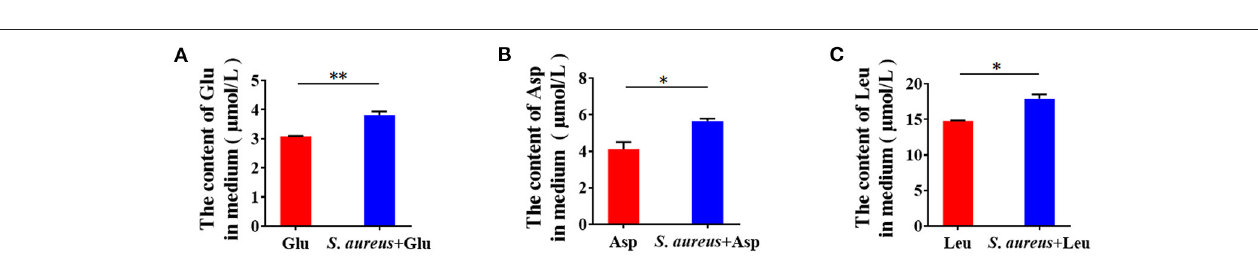
FIGURE 2 | Staphylococcus aureus invasion prevents amino acid uptake in BMECs 8h after infection. (A–C) Glu (A) , Asp (B) , and Leu (C) content in medium. * p < 0.05; ** p < 0.01. n = 3 independent